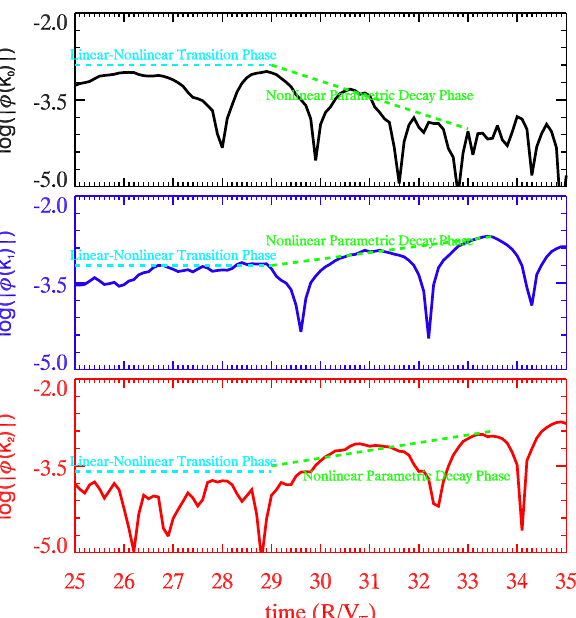
φ in the linear-nonlinear transition phase for the | |